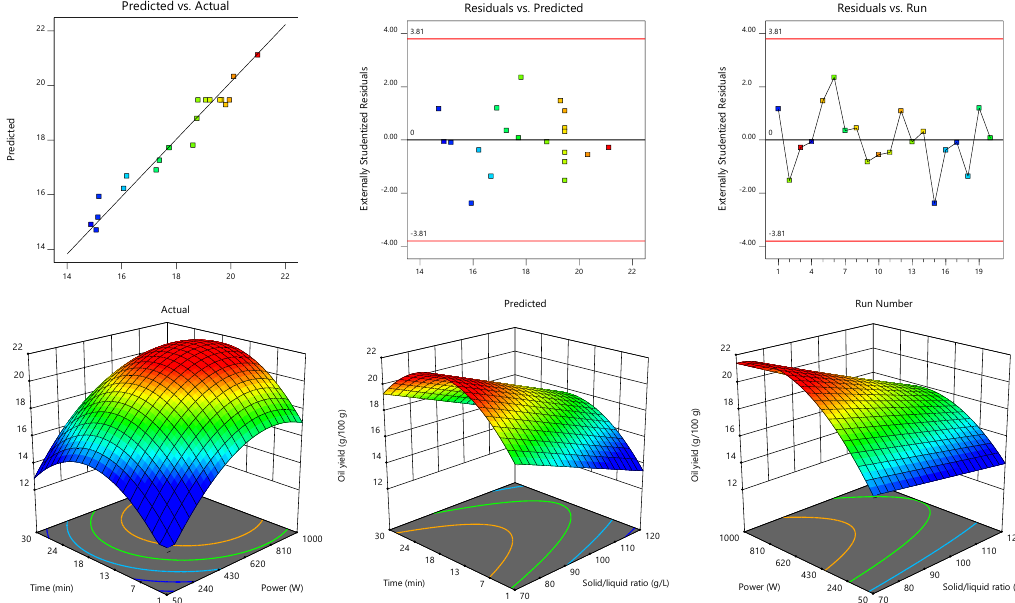
Figure 3. Response surface plots with statistical diagnostic representations illustrating the effects of the independent variables on oil yield (g/100 g) obtained from fish by-product S2 (frozen standard ground sample). For each 3D plot, the excluded variable was fixed at its optimal value. The 3D surface plots shown in Figures 2 and 3 were constructed to visually represent the effects of the process variables on the oil content obtained from S1 and S2, respectively. For each 3D plot, the excluded variable was fixed at its optimal value. The extraction